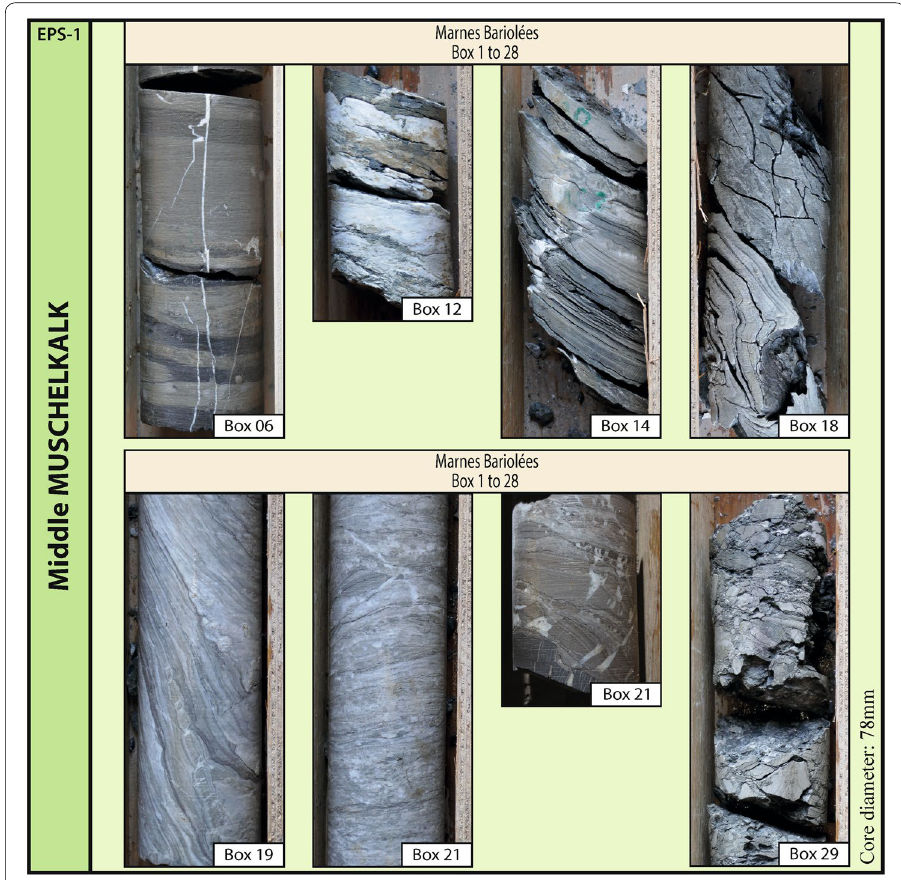
Fig. 3 Photo board of the cores from the middle Muschelkalk, with the Box associated with the cores; this package is correlated to a formation (with the name and boxes concerned). All the cores have a diameter of 78 mm. All the boxes correspond to the Marnes Bariolées formation. Box 06 corresponds to dolomite alternating with dolomitic marl with sealed fractures nearly vertical (in white). Box 12 shows great amount of anhydrite layer (in white) in the dolomitic formation (gray). Boxes 14, 18, 19 and 21 corresponds to dolomite strongly folded, with fractures (in white in the Box 14 and 21). Box 29 corresponds to a hydraulic breccia with mineralized